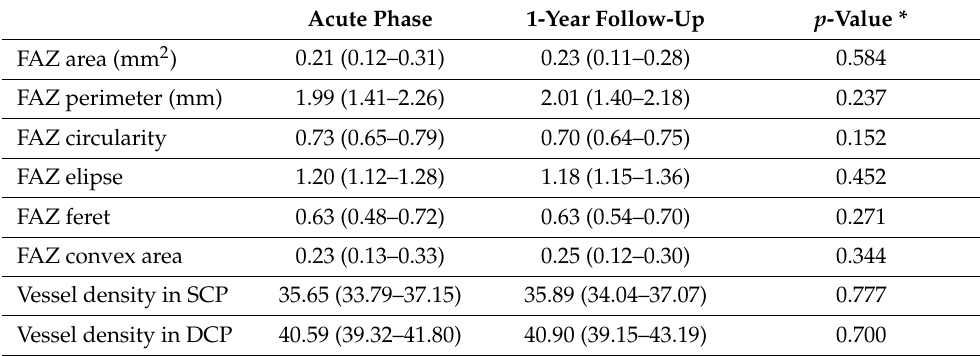
Table 3. Comparison of the OCTA parameters between the acute phase and 1-year follow-up. Acute